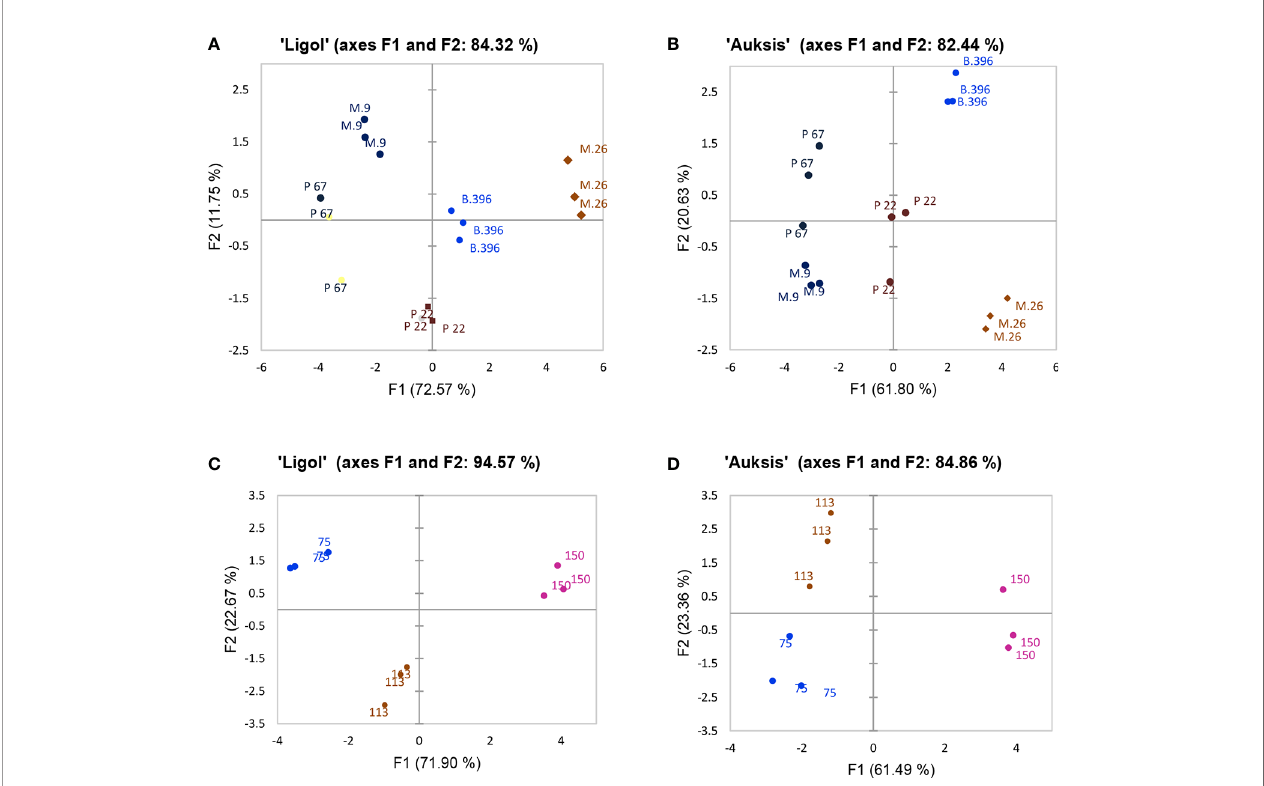
FIGURE 3 | The PCA scatterplot, indicating distinct differences in phytohormones, soluble sugars and return bloom depending on rootstock (A, C) and crop load (B, D) in “ Ligol ” and “ Auksis ” apple trees respectively. The analysis was conducted with all data resulting from 9 trees of “ Ligol ” and “ Auksis ” apple trees grafted on M.26, M.9, B.396, P 67, and P 22, with crop-load adjusted to 75, 113, and 150 fruits per tree.